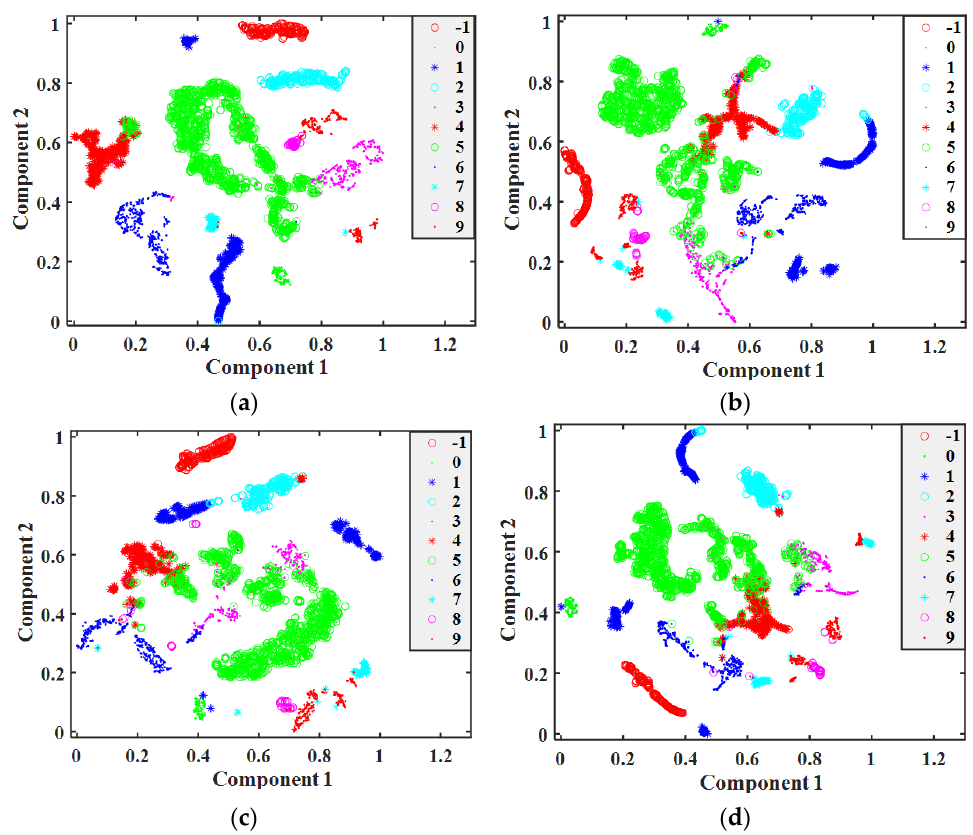
Figure 8. Visualization of the output feature T-SNE reduction: ( a ) the proposed model; ( b ) BP–ANN; ( c ) CNN; ( d ) BiLSTM.